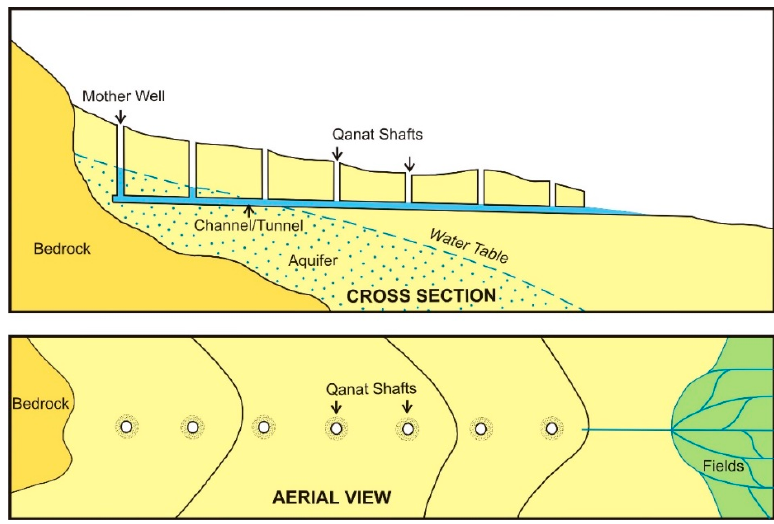
Figure 1. Schematic diagram of a qanat in mountain or hilly area. Courtesy of Dale Lightfoot. Remote Sens. 2020 , 12 , x FOR PEER REVIEW